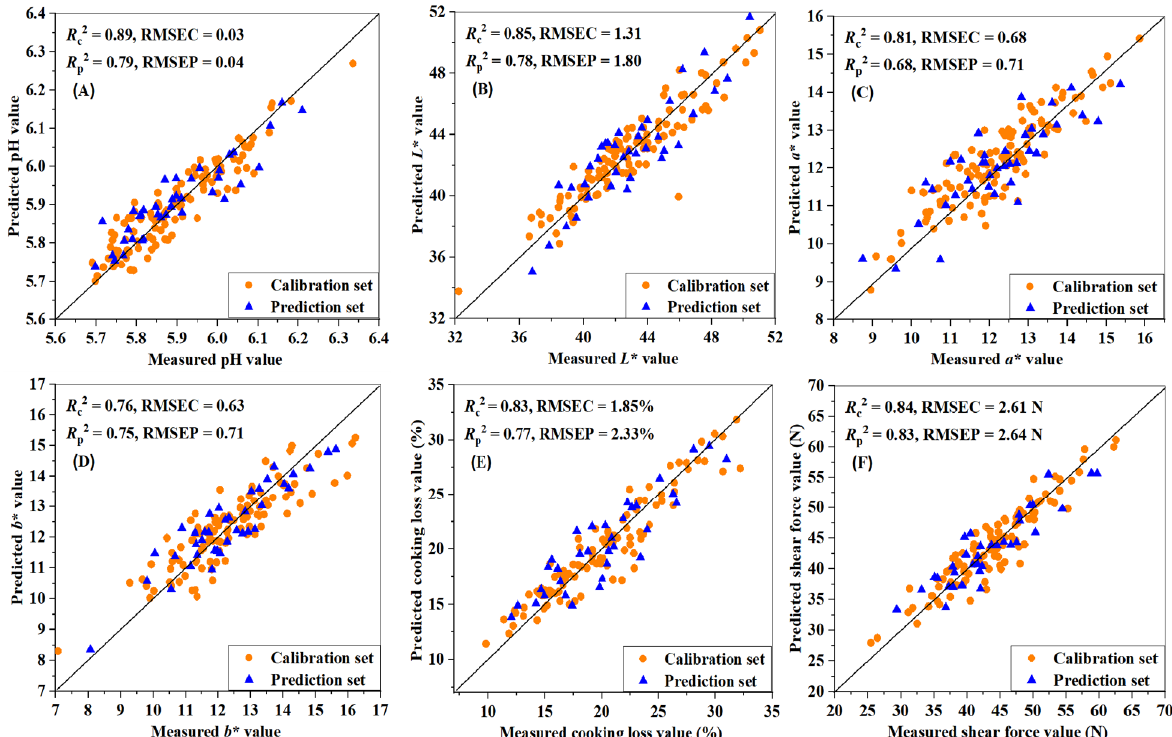
Figure 3. The prediction performances between the measured and predicted values for ( A ) pH, ( B ) L *, ( C ) a *, ( D ) b *, ( E ) cooking loss and ( F ) shear force. The results show the ability to predict the physicochemical properties using Vis/NIR spectroscopy combined with the PLSR algorithm. The closer the sample points to the straight line, the more precise the predicted value, which illustrates that the prediction model is more accurate and robust.